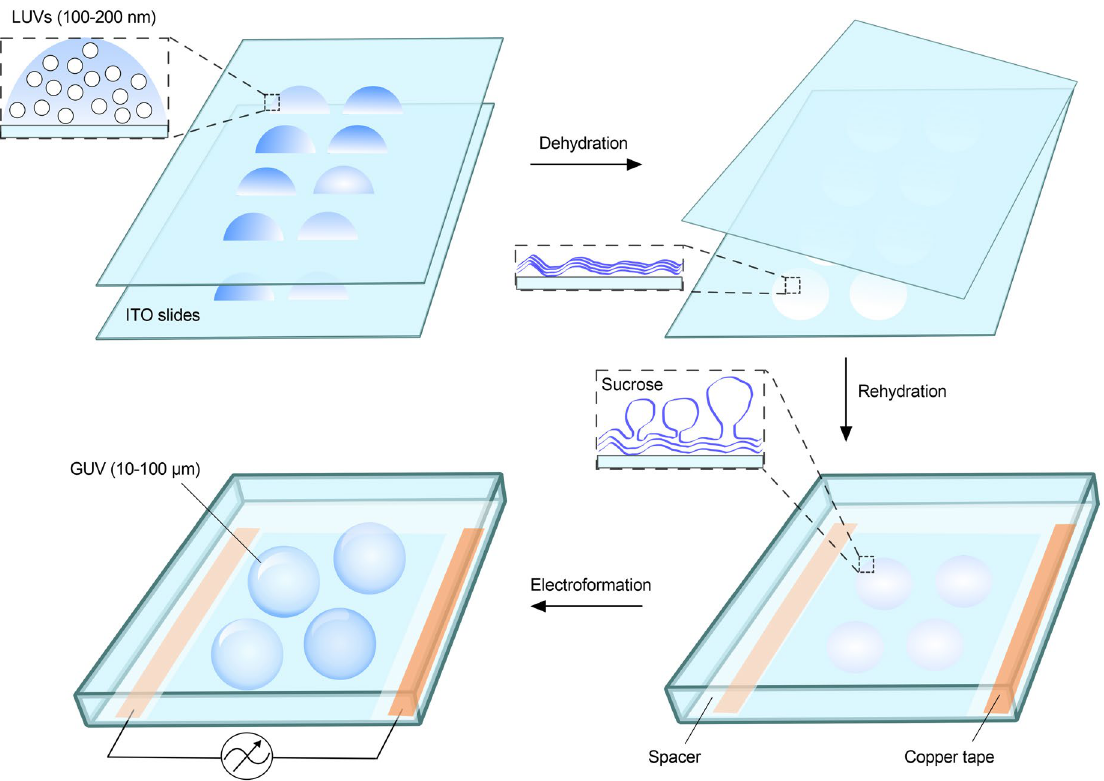
Figure 2. Electroformation of GUVs. Liposomes (LUVs) diluted in distilled water, are applied in droplets on the conductive surface of each of two glass slides coated with indium tin oxide (ITO). The solution is dehydrated overnight in a chamber containing saturated sodium chloride, resulting in the formation of a thin lipid film. The two slides are then assembled into a chamber so that the conducting surfaces with the lipid film face each other, separated by a Teflon spacer containing copper tape on each side. The chamber is sealed and held together by clamps (not illustrated), before being connected to a power source and exposed to an oscillating electric field upon injection of 250 mM sucrose solution, resulting in GUV formation. Protein-containing GUVs are generated similarly using (Fig. 3d). Multilamellar or multivesicular GUVs with encapsulated vesicles represented only a small fraction of the population (Fig. 3d). These observations are consistent with previous reports showing that application of a thin lipid film on a surface exposed to an electric field results in a high fraction of unilamellar GUVs 28 . Because of the inaccessible internal bilayers of multilamellar or multivesicular, the latter GUV types were excluded from our analyses. Phospholipid scrambling in GUVs detected by dithionite-mediated bleaching of ATTO488-PE. Next, we sought to investigate scramblase activity in pGUVs. To establish the necessary pro- tocols, we first tested the reactivity of ATTO488-PE to dithionite in eGUVs. A trace amount of biotin-PE was included when preparing protein-free liposomes to promote immobilization of the resulting eGUVs on avi- din–biotin-PEGylated cover glass slides in an incubation chamber (Fig. 4a). The eGUVs were imaged via their ATTO488-PE fluorescence (Fig. 4c, t = 0 min). A small volume (1% of the aqueous volume in the chamber) of dithionite solution was added gently to the chamber (Fig. 4a, bottom panel), without overt mixing in order not to disturb the settled/attached eGUVs. A time series of fluorescence images was captured over the next 12 min (Fig. 4c, upper panels). Buffer treatment was performed in parallel (Fig. 4c, lower panels). The ATTO488-PE fluorescence intensity of individual eGUVs before, and at different time points after dithionite or buffer addition, was quantified by image analysis using ImageJ as follows (Fig. 4b). An outline of individual GUVs was manu- ally defined based on the fluorescence of ATTO488-PE. Membrane fluorescence was quantified by a circular region of interest (ROI) around each GUV, measuring the integrated density value (Fig. 4b). A ROI in the lumen of the individual GUV was used to quantify the background signal per pixel, which was then subtracted from the membrane signal by multiplying with the area of the membrane ROI. The background signal was typically insignificant but was nevertheless used as an offset correction as part of our standard procedure. We observed some movement of the eGUVs on addition of either buffer or dithionite. The movement occurred within and along the focus plane on the microscope slide indicating that the GUVs were not completely immobilized via the avidin–biotin-PEG system. Nevertheless, it was possible to track a sufficient number of individual GUVs that stayed within the field of view due to sedimentation, as indicated in Fig. 4c, and to quantify their ATTO488 fluorescence before and after dithionite treatment (Fig. 4b,d).